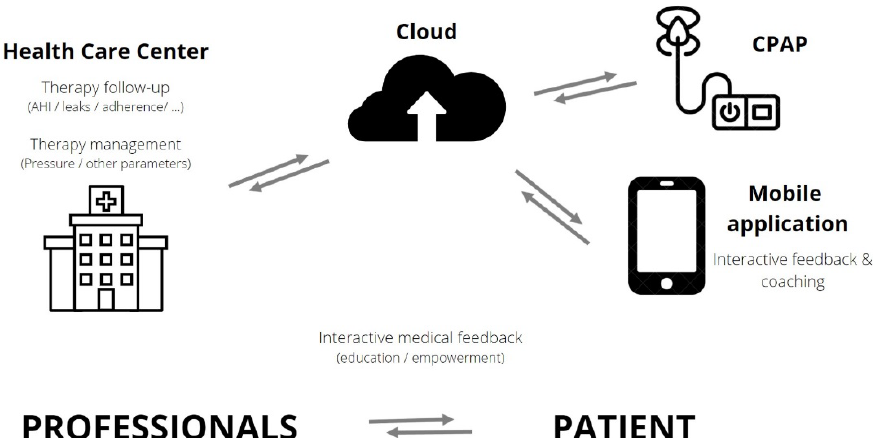
Figure 1. Interactions between patients and healthcare professionals in telemonitored CPAP-treated OSA patients. OSA: obstructive sleep apnea–hypopnea; CPAP: continuous positive airway pressure; AHI: apnea–hypopnea